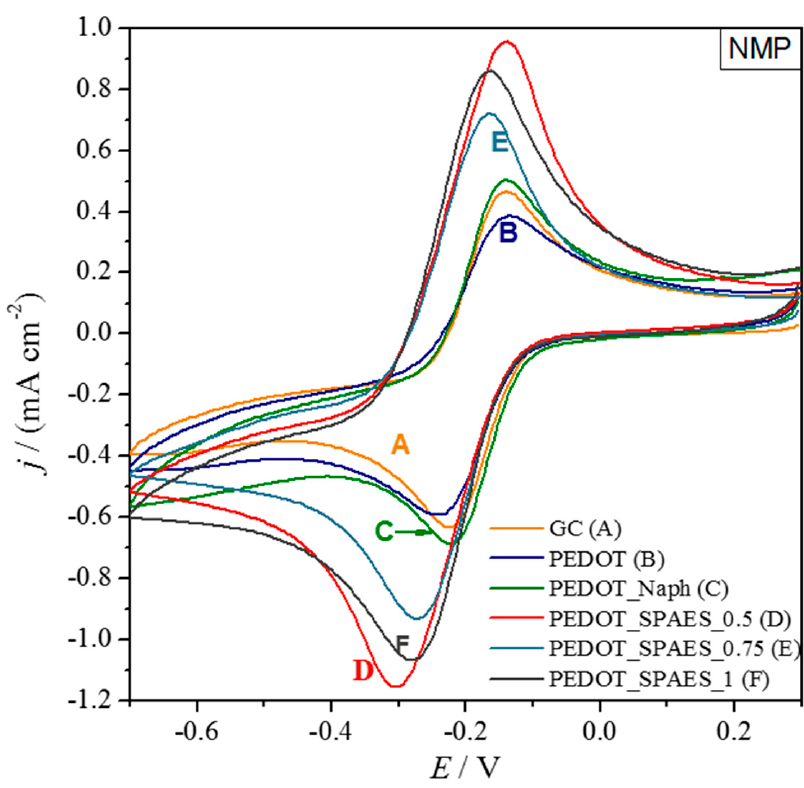
Figure 9. Cyclic voltammograms of bare glassy carbon (GC) and modified GC with polymers dissolved in NMP (Table A4). The electrochemical probe is 3 mM [Ru(NH 3 ) 6 ]Cl 3 .